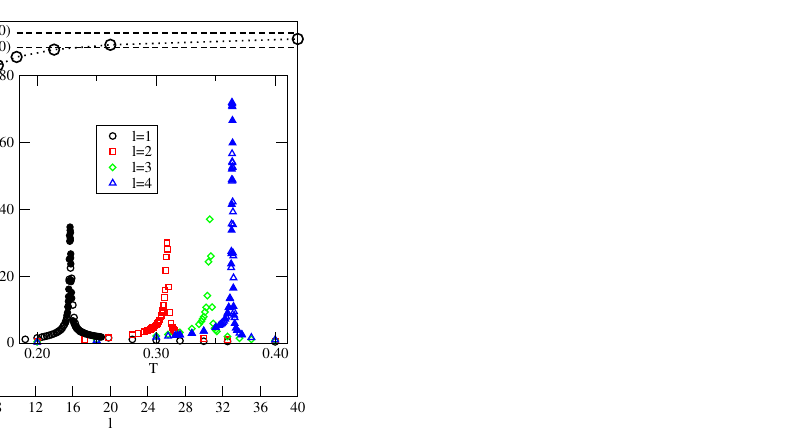
Figure 23. The main part shows the changes of the order–disorder transition temperature versus the number of fully occupied layers in the system with u BB = 0 and u AB = − 1.0. Horizontal dashed lines mark the locations of T tr ( u AB = − 1.0 ) and T o ( u AB = − 1.0 ) . The inset gives examples of the heat capacity curves for the film of different thickness. The open and filled symbols correspond to the results for the simulation cells with L = 40 and 60,